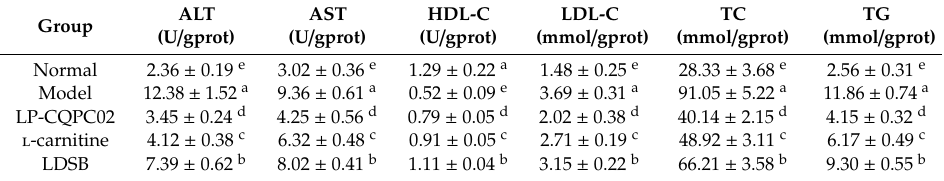
Table 6. Levels of ALT, AST, HDL-C, LDL-C, TC and TG in hepatic tissue of mouse ( n = 10).